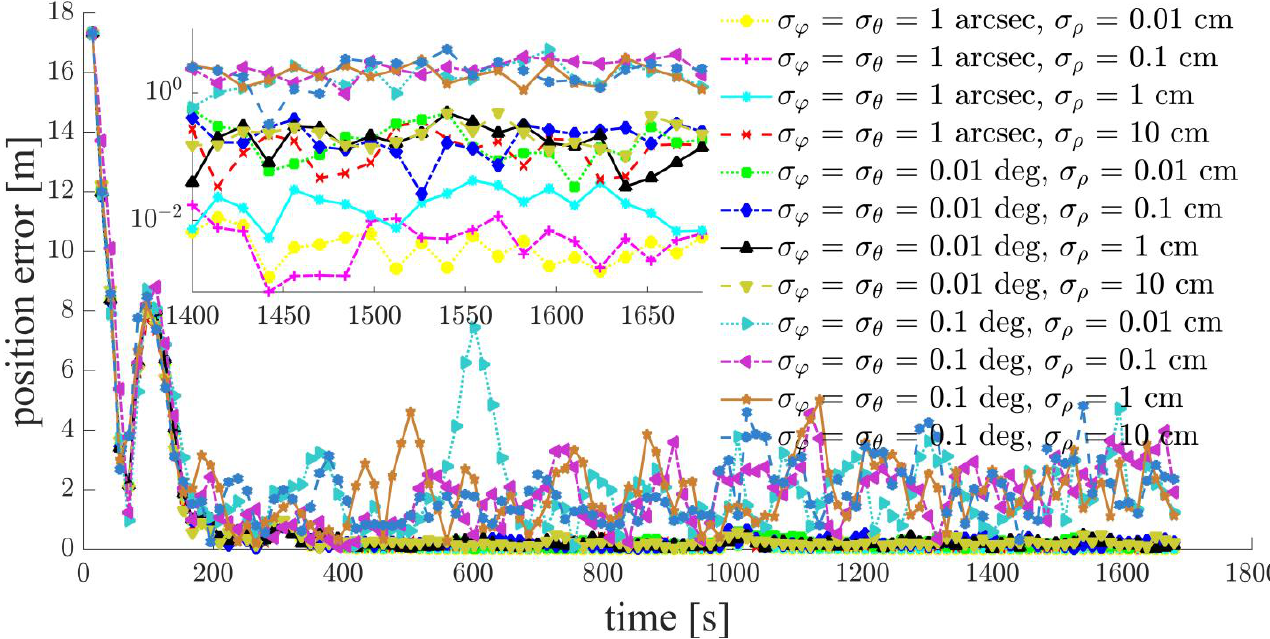
Figure 13. Relative navigation errors of 𝑆 3 (simulated scenario: Case d, space-circle formation radius of 1 km).